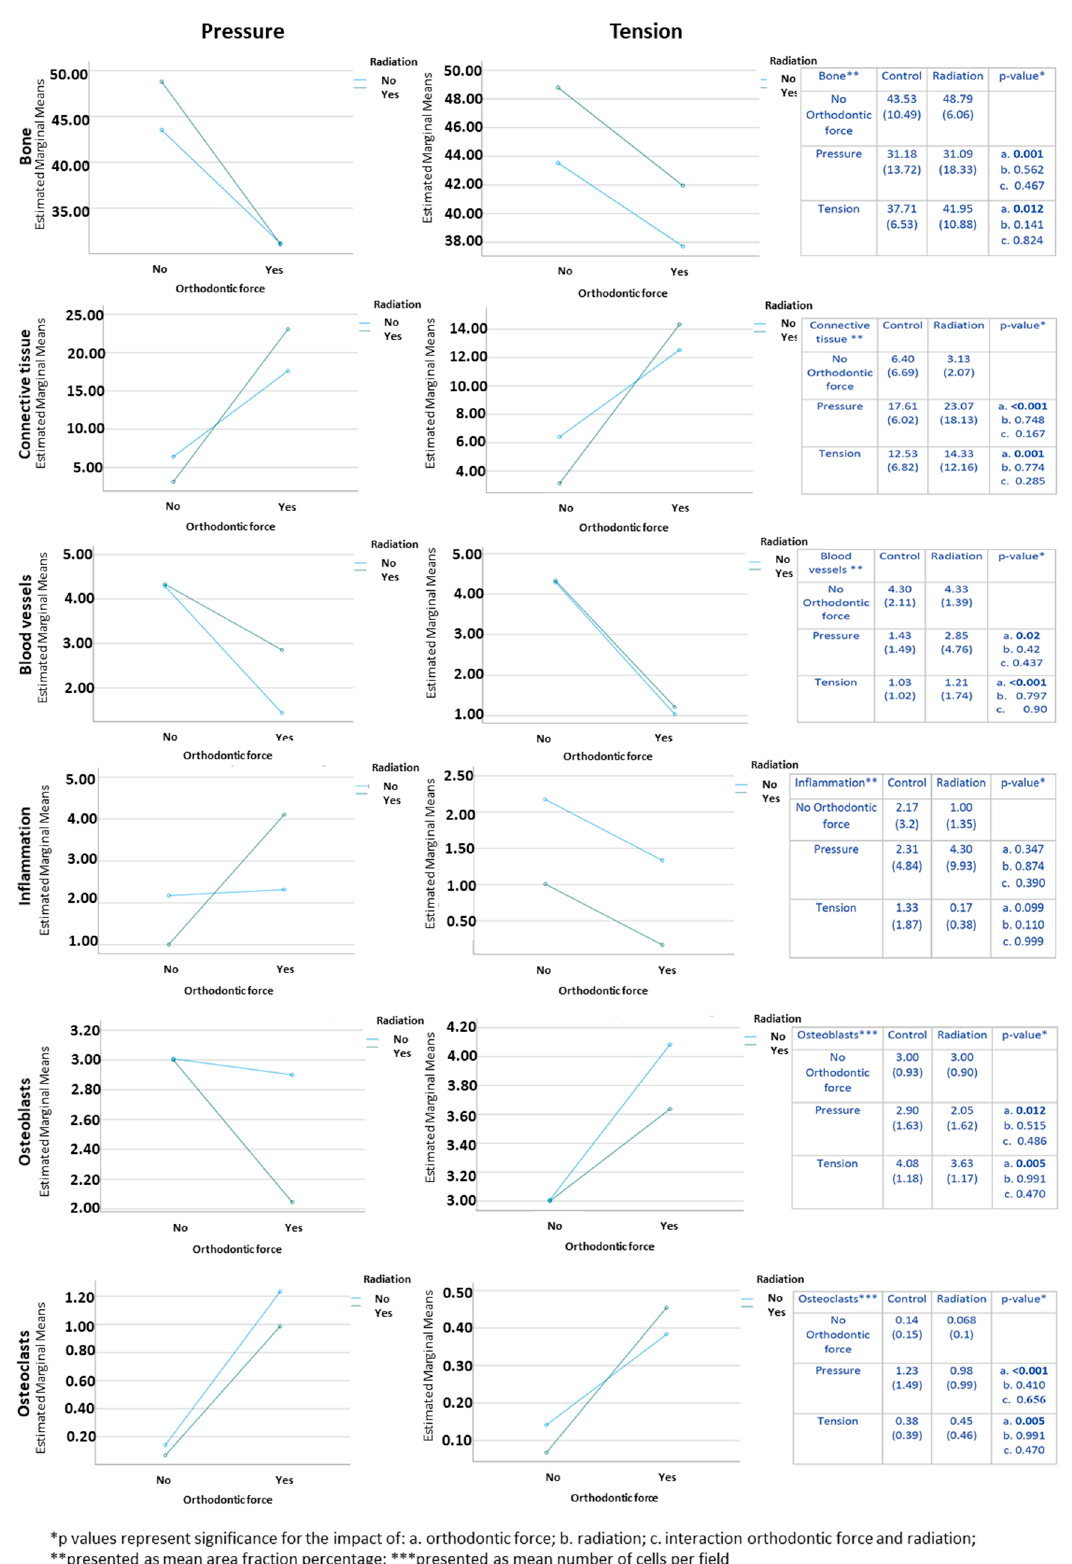
Figure 3. Histomorphometric changes in bone, connective tissue, blood vessels, inflammation, osteoclasts, and osteoblasts as a factor of orthodontic force and